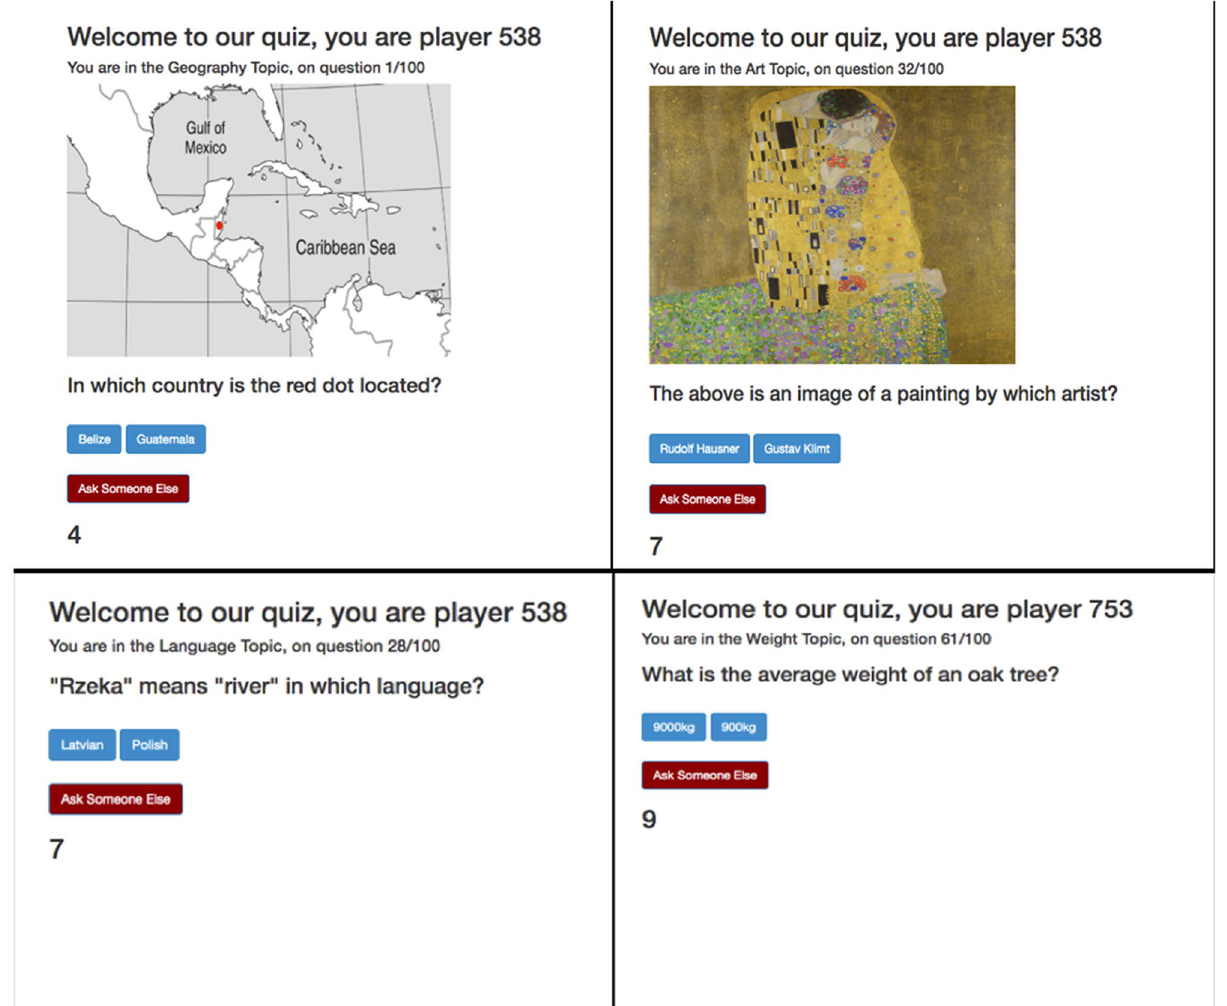
Figure 1. Four example screenshots representing questions from the Geography, Art, Language and Weight topics as seen by participants. Half the questions from each topic included images and half did not. Participants could either click one of the two blue buttons showing two possible answers (one correct, one incorrect), or click the red button which allows participants to copy someone else within their group. The number at the bottom is a countdown timer that forces participants to answer within 15 s. Player ID numbers are generated randomly for each participant when they begin the quiz. Here, three example screenshots come from one player (ID 538) and one from another player (ID 753). In reality, all participants view each question simultaneously. Note: all map images used in the quiz were sourced from https ://www.edupl ace.com/ss/maps/ and edited